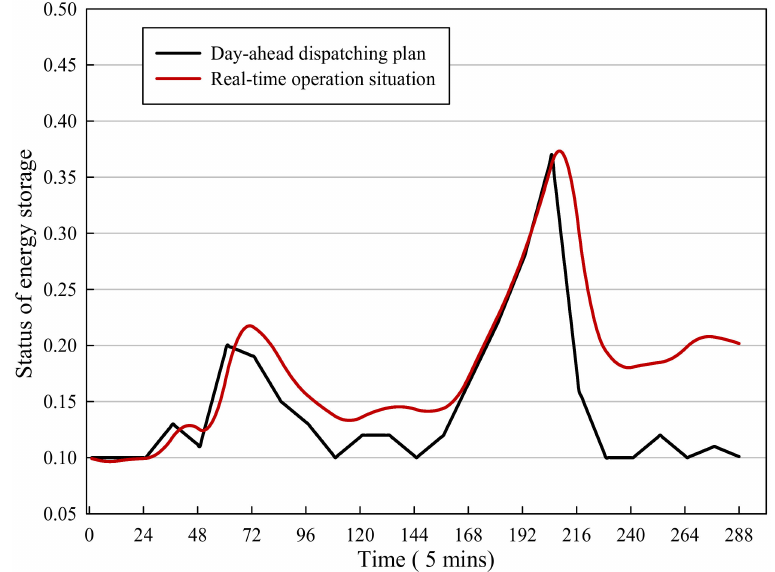
Figure 14. Comparison of operating status of heat energy storage equipment under real-time and day-ahead dispatching